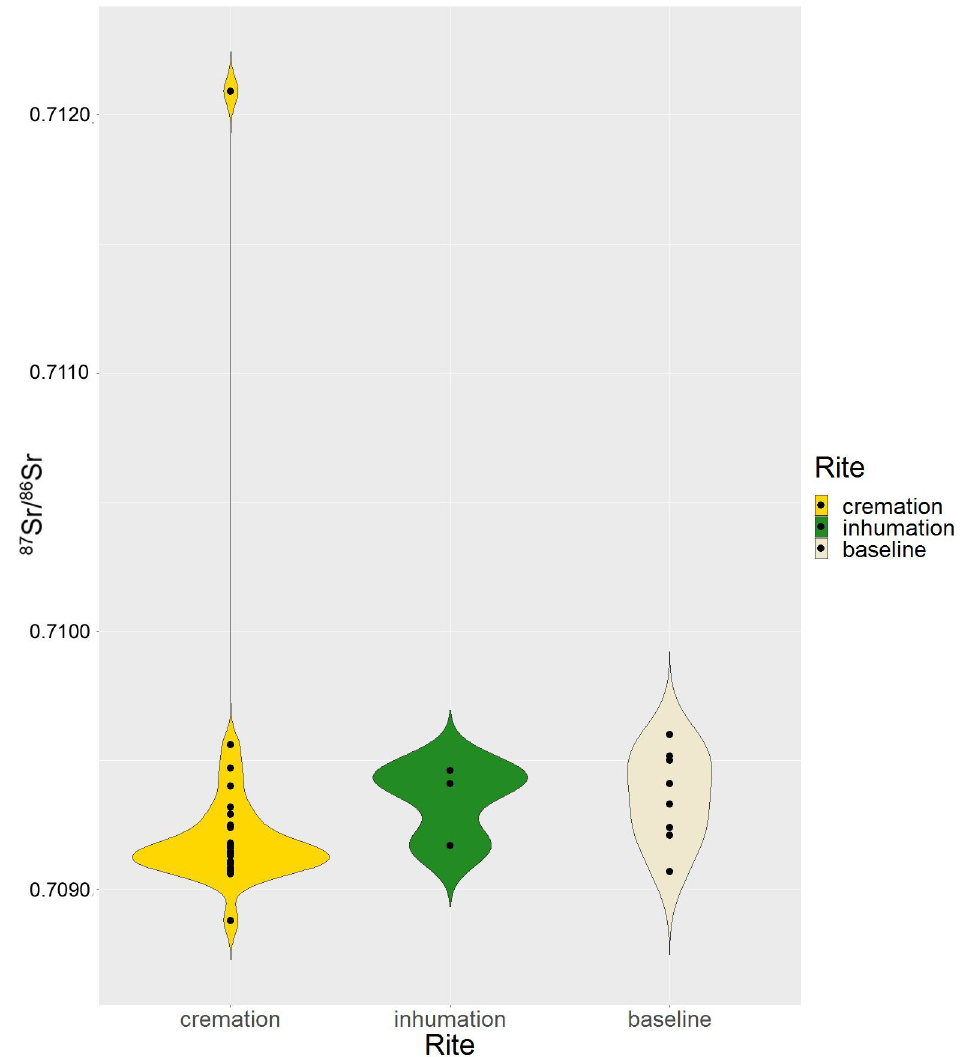
Fig 7. Violin plot. Distribution of the 87 Sr/ 86 Sr values of cremations and inhumations compared with local baselines at Szigetszentmiklo´s.